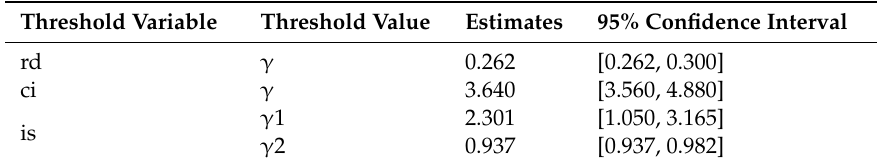
Threshold estimation results and confidence intervals of foreign investment and carbon emissions.